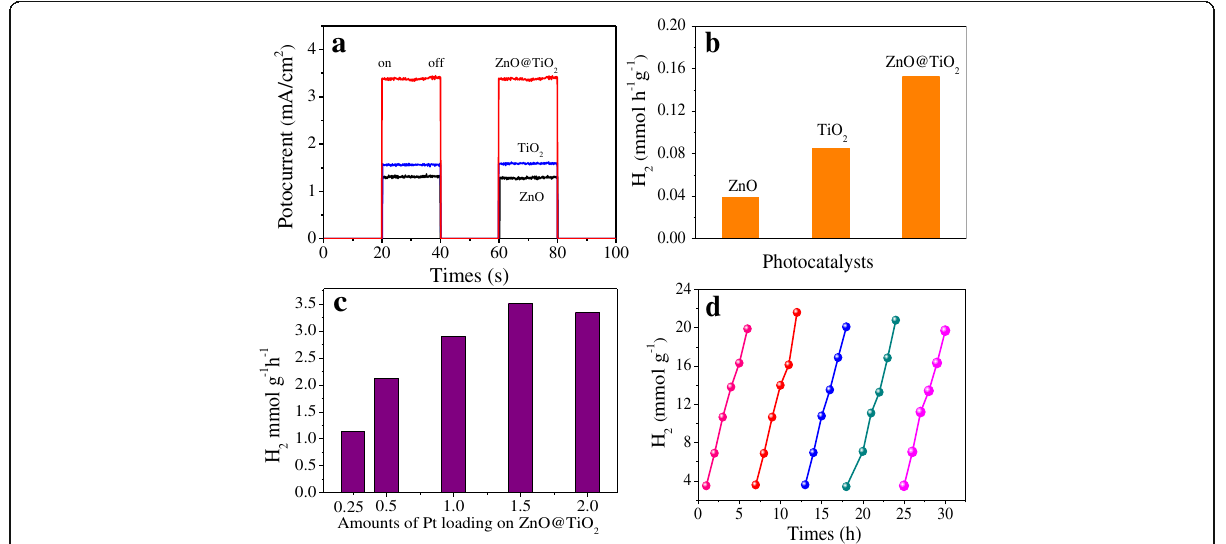
Fig. 5 a Photocurrent responses and b photocatalytic H 2 evolution of bare ZnO, bare TiO 2 , and ZnO@TiO 2 heterojunctions. c Photocatalytic H 2 evolution over Pt – ZnO@TiO 2 heterojunctions composites with different weight ratios of Pt. d Photocatalytic stability of ZnO@TiO 2 hollow spheres. All the measurement was carried out under a simulated solar light irradiation source with intensity of 100 mW/cm